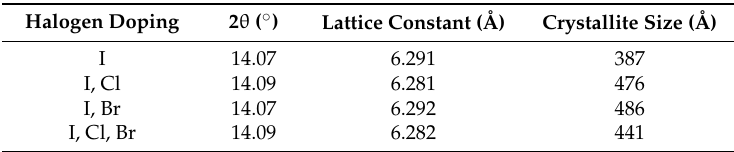
Table 4. Measured parameters of CH 3 NH 3 PbI 3 ´ x Br x solar cells.